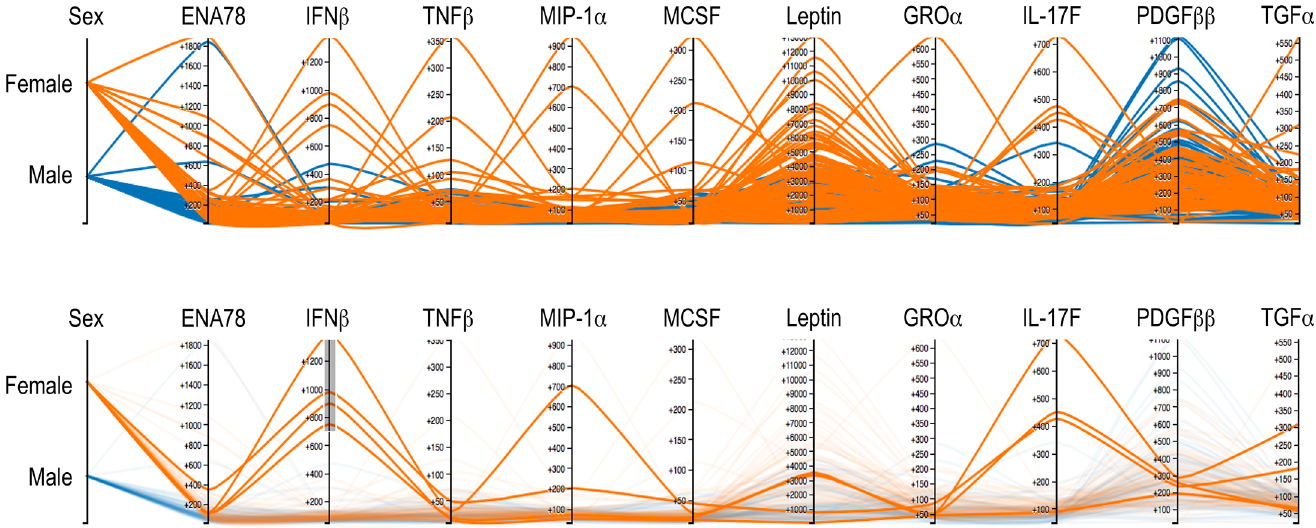
Fig 6. Example of multivariate visualization using parallel coordinates (http://earlybird.cytoanalytics.com). Results for the ten serum cytokines with highest variability are shown, with individuals colored by sex. Each analyte is displayed on its own vertical axis, with the axis range corresponding to the data range. Each line represents one person, and intersects each axis at the appropriate value (MFI) for that person. With the exception of PDGF ββ , it is clear that the highest outliers are all females. By selectively highlighting the top individuals for IFN β (bottom panel), it becomes apparent that many of these individuals are “ serial outliers ” , i.e., high for other cytokines as well. This implies a minority phenotype of females with multiple high serum cytokine levels.